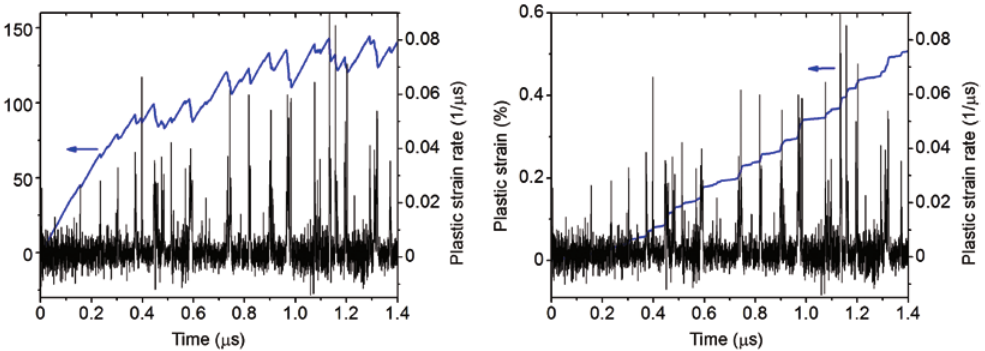
Figure 3: Stress, plastic strain rate, and plastic strain vs. time signals in a DDD simulation of uniaxial compression; left, plastic strain vs. time and plastic strain rate vs. time; right, stress vs. time and plastic strain rate vs.